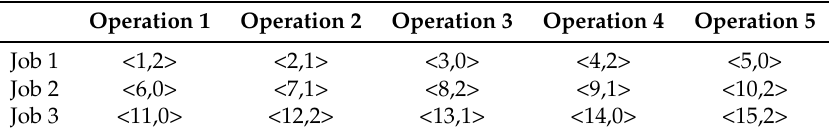
Table A1. Machine assignment of operations of the small instance.